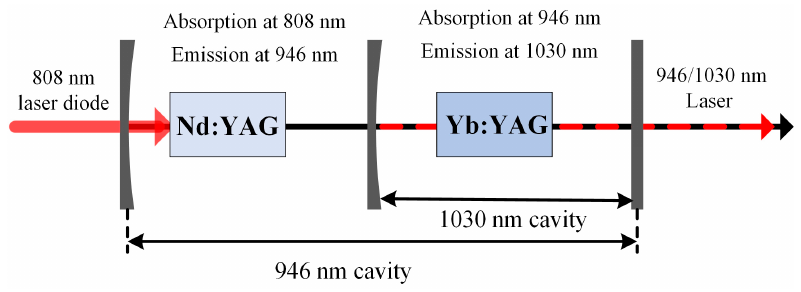
Figure 2. The operation schematic of the intracavity cascading pumped method. In end-pumped solid-state lasers, different modes of laser can be obtained based on the pump light with different irradiance distribution or pumping off-axis gain medium, such as the TEM 00 mode, Hermite–Gaussian (HG) mode, and LG mode. The TEM 00 mode laser is obtained when the light source with point irradiance distribution pumps the gain medium along the direction of the optical axis, which is the pump source and pumping method used in the vast majority of lasers at present [32,33]. The HG mode laser can be excited by pumping off-axis with the help of a fiber-coupled laser diode, and the order of the HG laser will be increased as the transverse separation of the fiber from the optical axis increases [34,35]. In addition, the HG mode laser can be converted to an LG mode laser using a cylindrical lens set outside the resonant cavity, which is also an indirect method to obtain the LG mode laser [36]. However, a laser with annular-shaped irradiance distribution end-pumped gain media is currently more common for obtaining the LG laser [37,38]. Because the pump beam with an annular-shaped irradiance distribution and the LG laser has good mode-matching effects in the gain medium, the LG laser can be obtained directly in the cavity based on this method. In the previous work, we obtained a 946 nm LG 01 mode vortex laser by end-pumped Nd:YAG crystal with an 808 nm annular beam [39]. The 946 nm LG 01 mode vortex laser has a two-lobe transverse irradiance distribution at any position in the cavity. Meanwhile, the light irradiance of a 946 nm LG 01 mode vortex laser within a distance is superposed in the resonator to obtain an annular distribution, which can achieve a good mode-matching effect with a 1030 nm vortex laser equipped with Yb:YAG